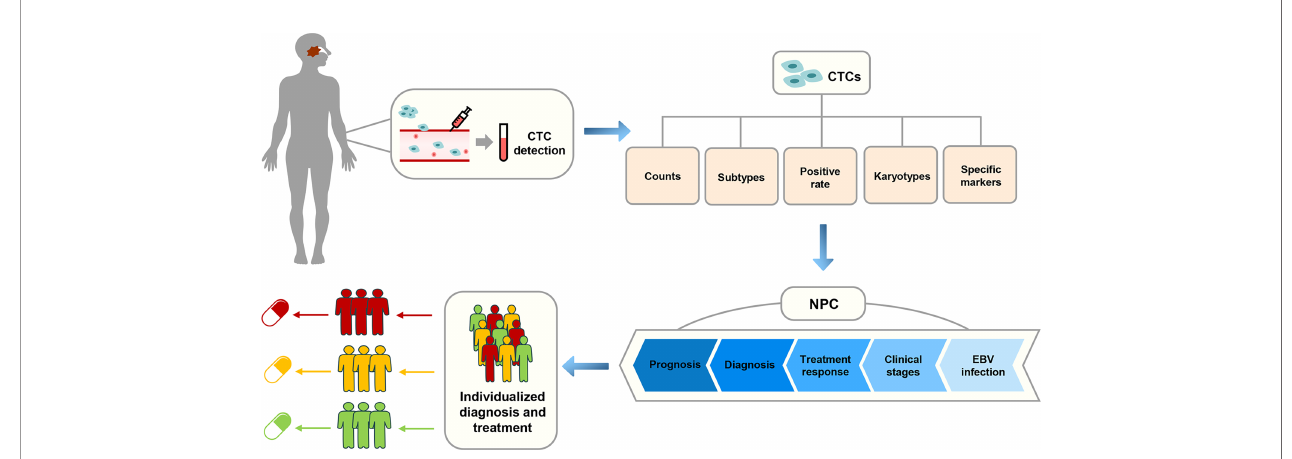
FIGURE 2 | The correlation between the application of CTCs and the individualized diagnosis and treatment of NPC in clinical